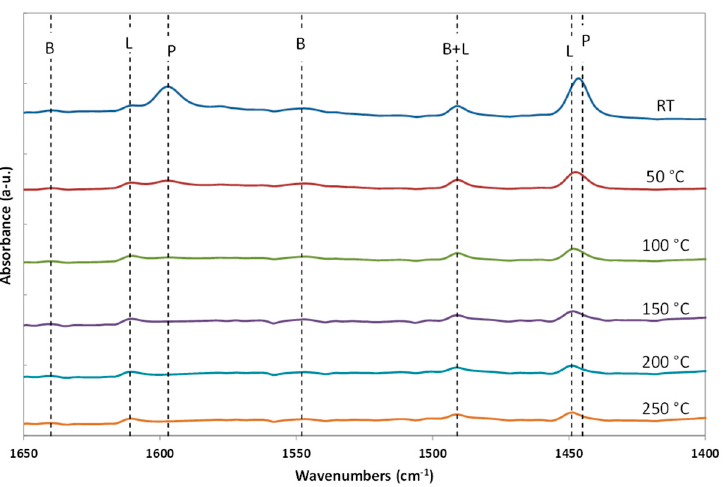
Figure 3. FT-IR pyridine adsorption and desorption spectra, recorded at different desorption temperatures for NbO x -SiO 2 . Pyridine adsorption at room temperature. Desorption steps were performed from room temperature to 250 °C. L and B marks show the location of bands attributed to Lewis and Brønsted acid sites, respectively.